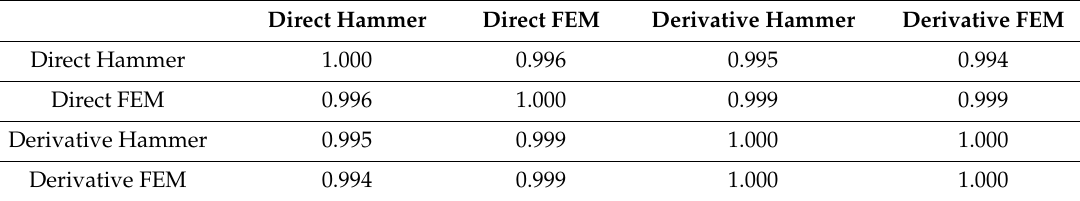
Table 6. MAC values for the first rotational mode for the UHPC2_L beam. Intact state. Direct Hammer Direct FEM Derivative